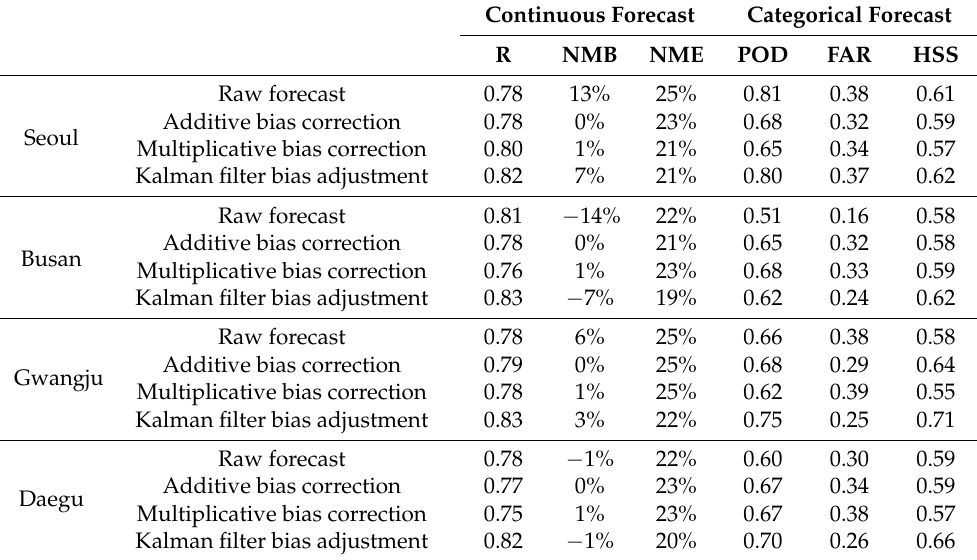
Table 8. Performance comparison of continuous and categorical forecast between the additive bias correction, multiplicative bias correction, Kalman filter bias adjustment at Seoul, Busan, Gwangju, Daegu in